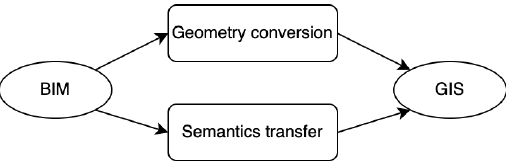
Figure 1. The basic pattern for BIM-to-GIS data